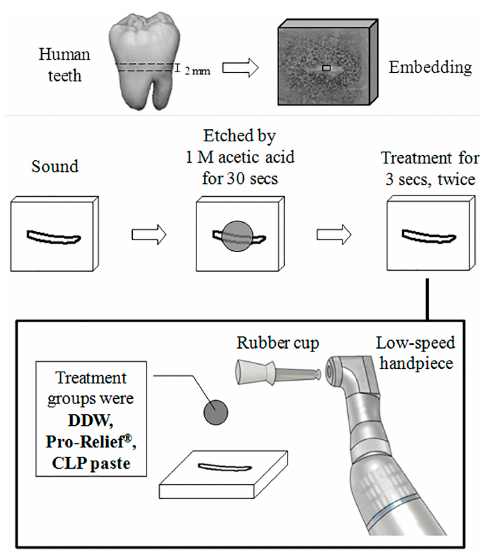
Figure 1. Illustration of the sample preparation and experimental procedure.